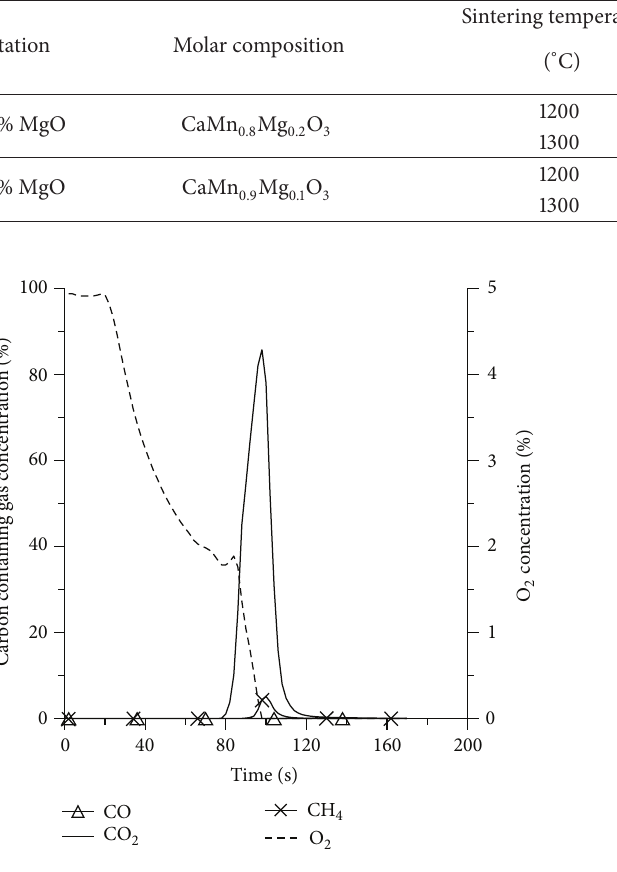
Figure 5: Dry gas concentration profile of the second methane cycle at 950 ∘ C on the 5.6% MgO 1300 sample.